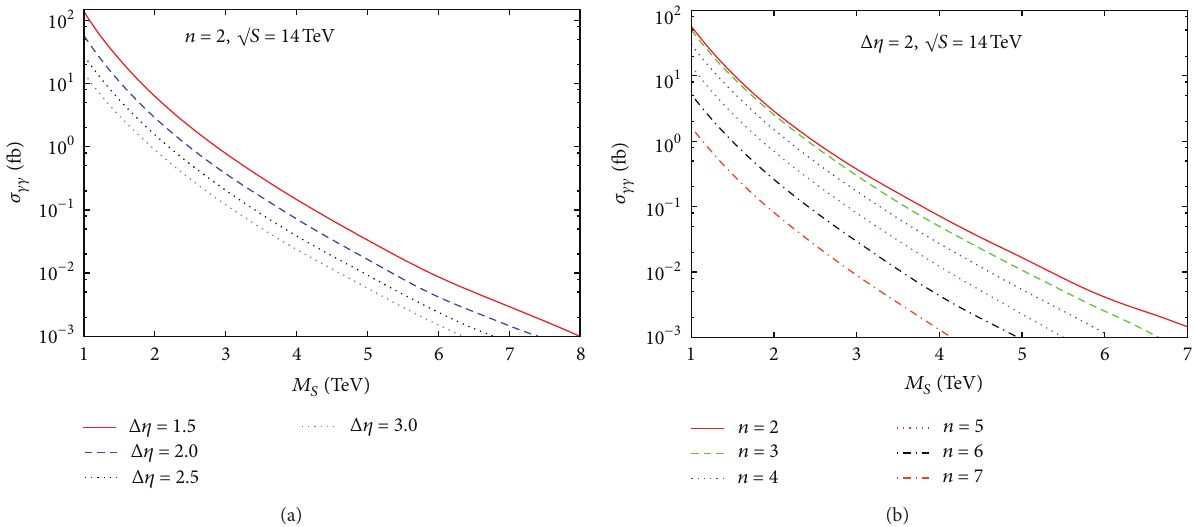
Figure 11: The total signal cross-sections ( 𝑝𝑝 → 𝑋 + 𝛾𝛾 + 𝑌 ) in diphoton channel ( 𝜎 𝛾𝛾 ) as a function of 𝑀 𝑆 at the 14TeV LHC. In (a), we plot 𝜎 𝛾𝛾 for Δ𝜂 = 1.5, 2.0, 2.5, and 3.0 for 𝑛 = 2 . In (b), we plot 𝜎 𝛾𝛾 for 𝑛 = 2 – 7 for Δ𝜂 = 2 . In both plots, 𝜎 𝛾𝛾 ’s are computed after applying the cut defined in